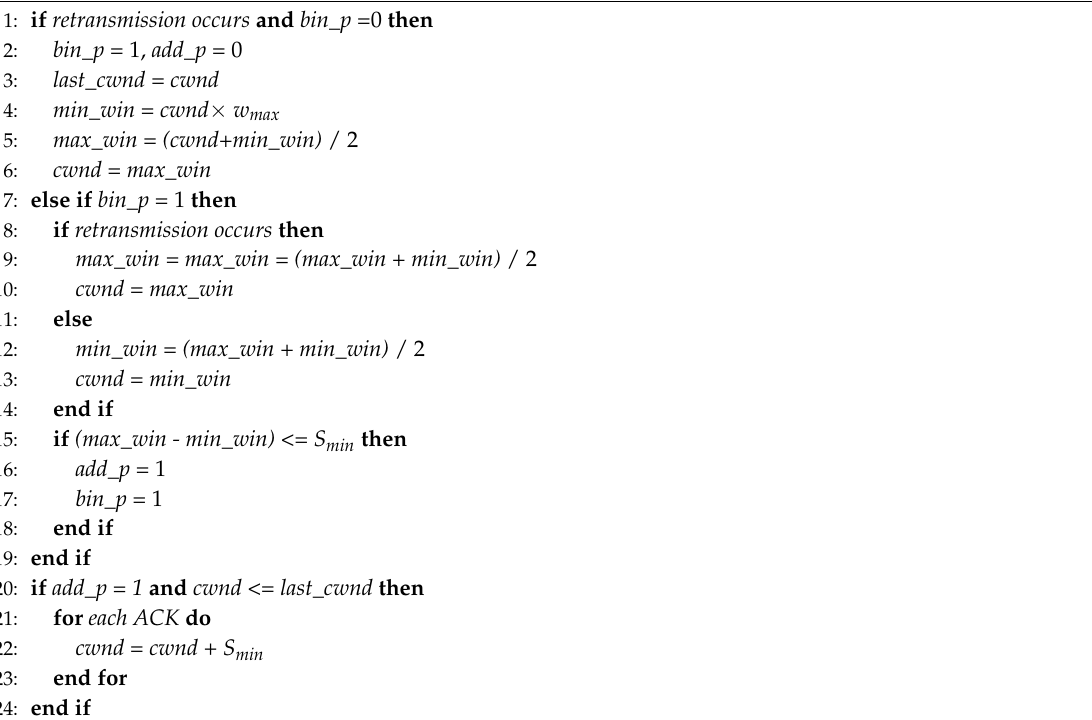
Algorithm 2 Modest BBR congestion control.